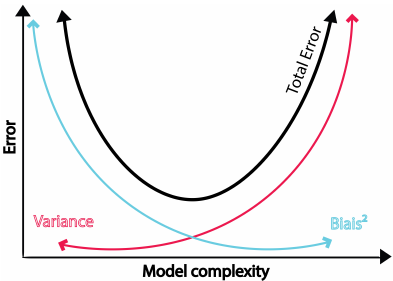
Figure 2. Bias-variance Tradeoff